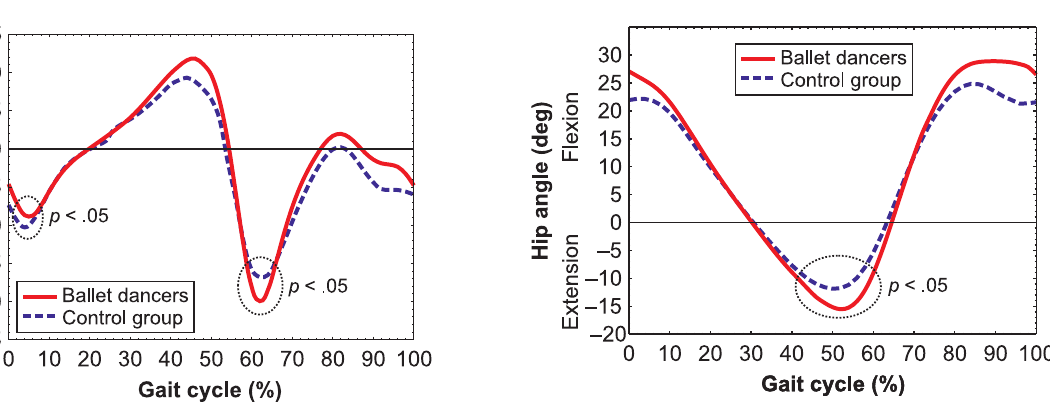
Figure 1. Ankle movement in the sagittal plane dur- ing gait in dancers and the control group